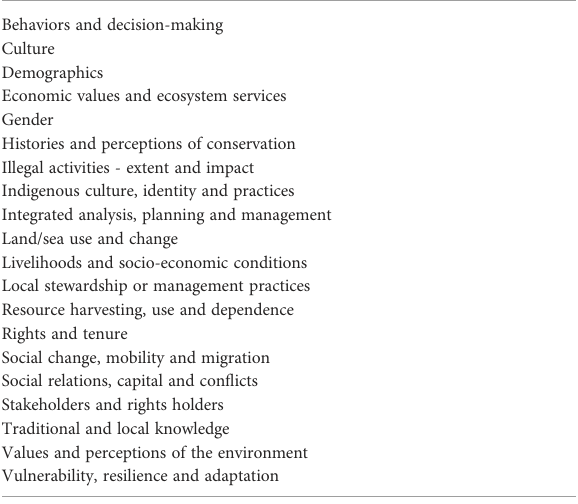
TABLE 2 Overview of social science topics that emerged from the interviews organized by their contribution to planning, doing and learning stages of conservation decision-making and adaptive management. Planning: Understanding the local social context and designing conservation approaches, plans, and management to